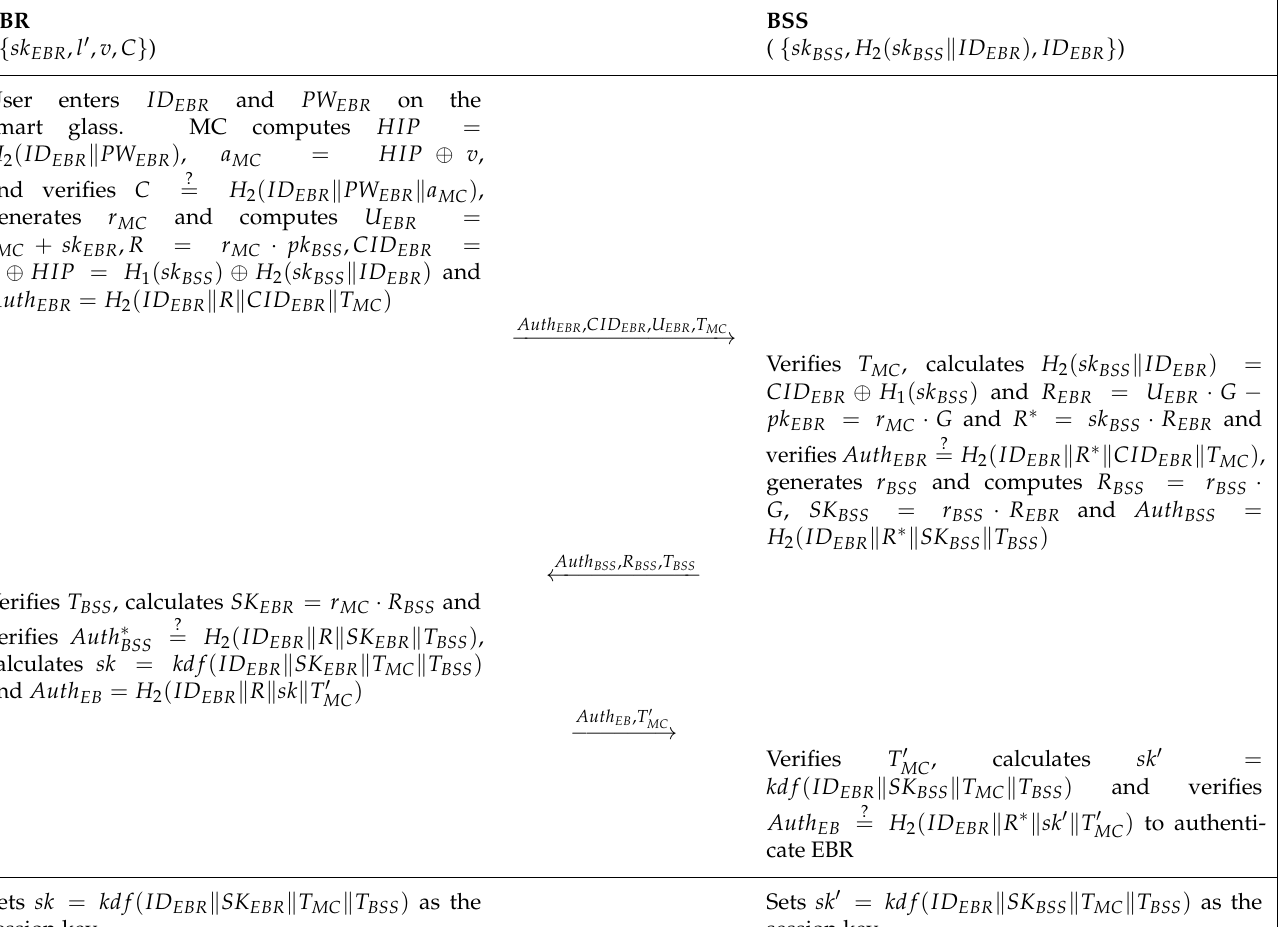
Figure 3. Mutual authentication phase of LLAKEP scheme to share a session key between EBR and BSS